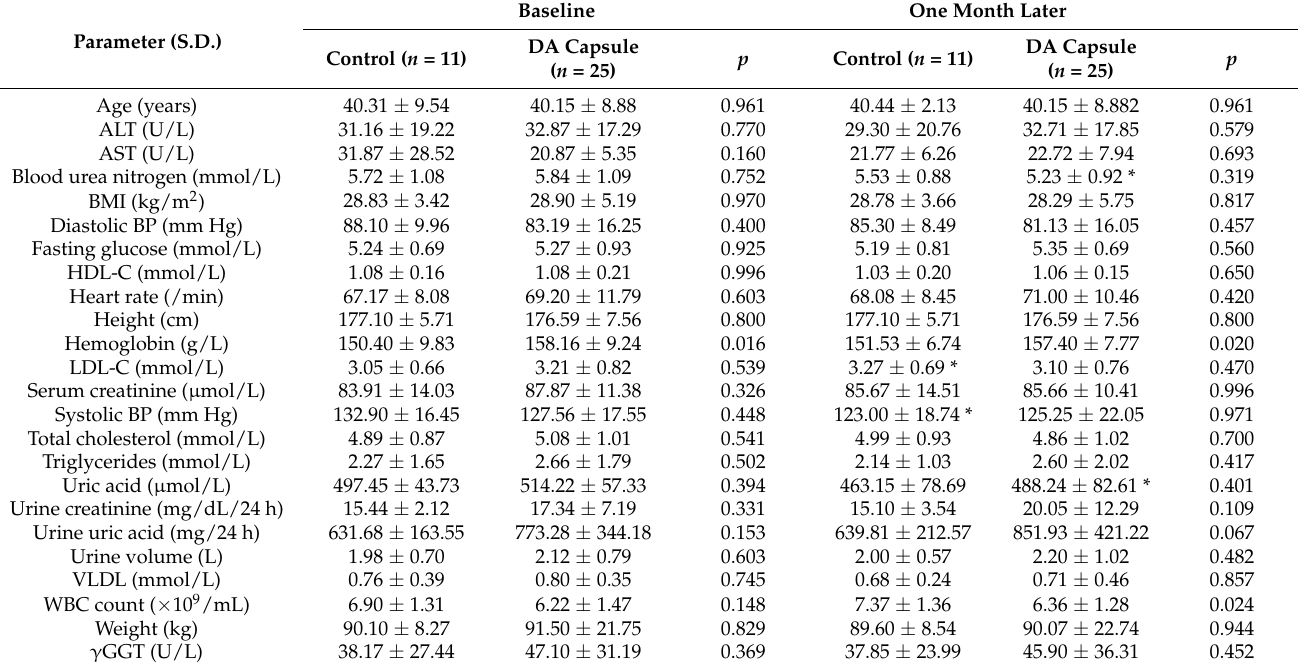
Table 1. Study subjects’ demographic